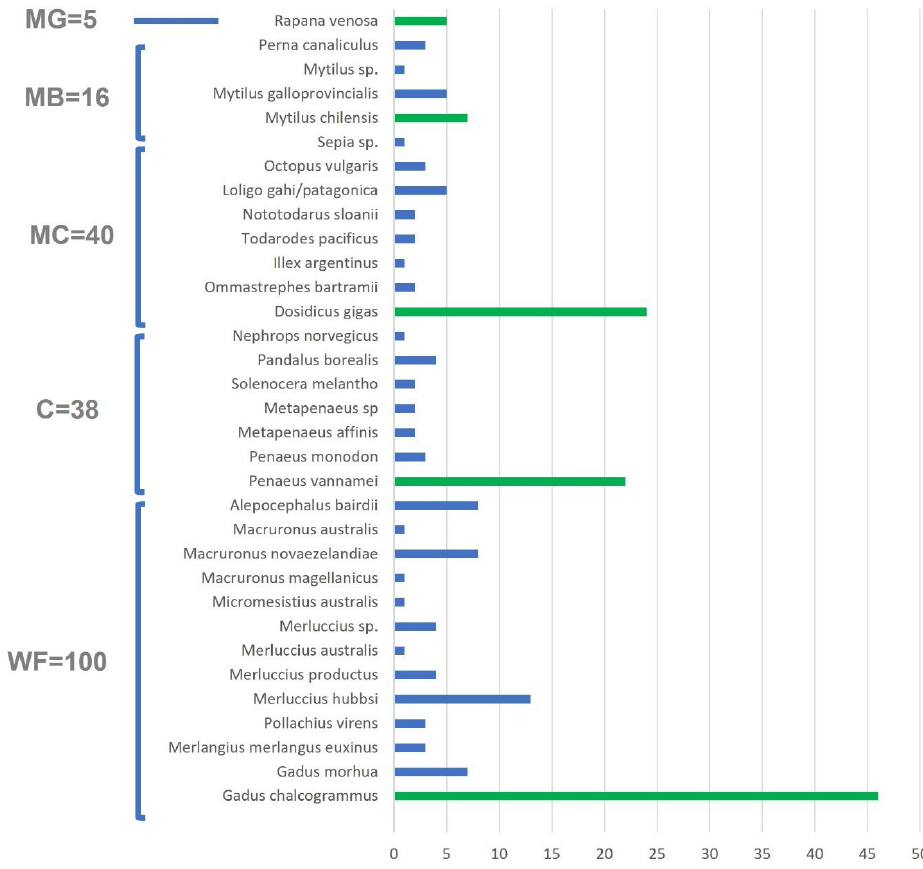
Figure 1. The number of seafood products collected during the sampling period at retail outlets per species declared on the label within each seafood taxonomical class (WF—fish; C—crustaceans; MC—cephalopods; MB—bivalve mollusks; MG—gastropods. In green, for each taxonomical class, the species most commonly encountered during sampling.